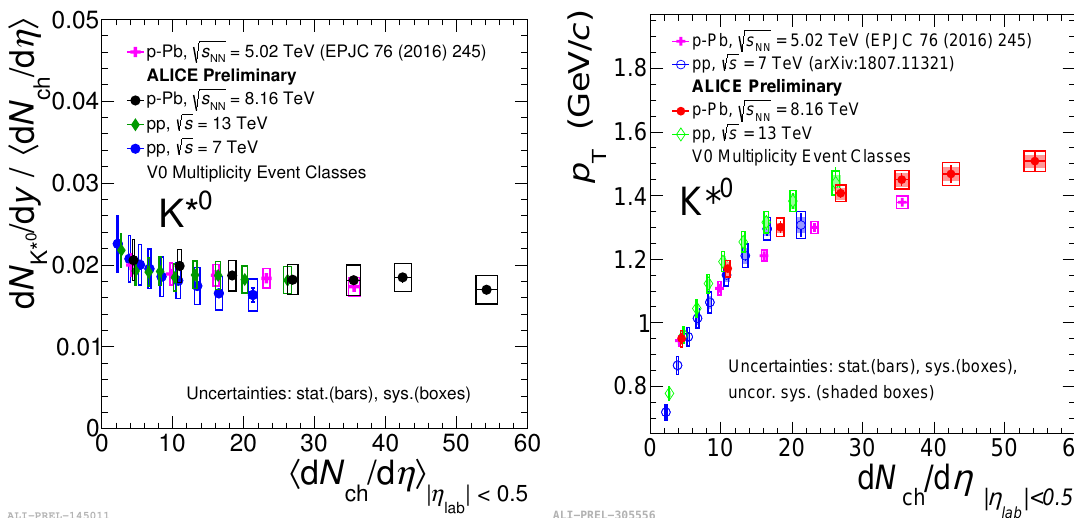
Figure 1. (Color online) Left panel: The integrated yields of K ∗ 0 normalised to (cid:104) d N ch /d η (cid:105) in pp collisions √ √ s = 7, 13 TeV and in p–Pb collisions at s NN = 5.02 , 8.16 TeV as a function of (cid:104) d N ch /d η (cid:105) . Right panel: at Mean transverse momentum ( (cid:104) p T (cid:105) ) of K ∗ 0 as a function of (cid:104) d N ch /d η (cid:105) in pp collisions at √ s NN = 5.02 , 8.16 TeV. Statistical uncertainties (bars) are shown together with total in p–Pb collisions at (hollow boxes) and multiplicity-uncorrelated (shaded boxes) systematic uncertainties.